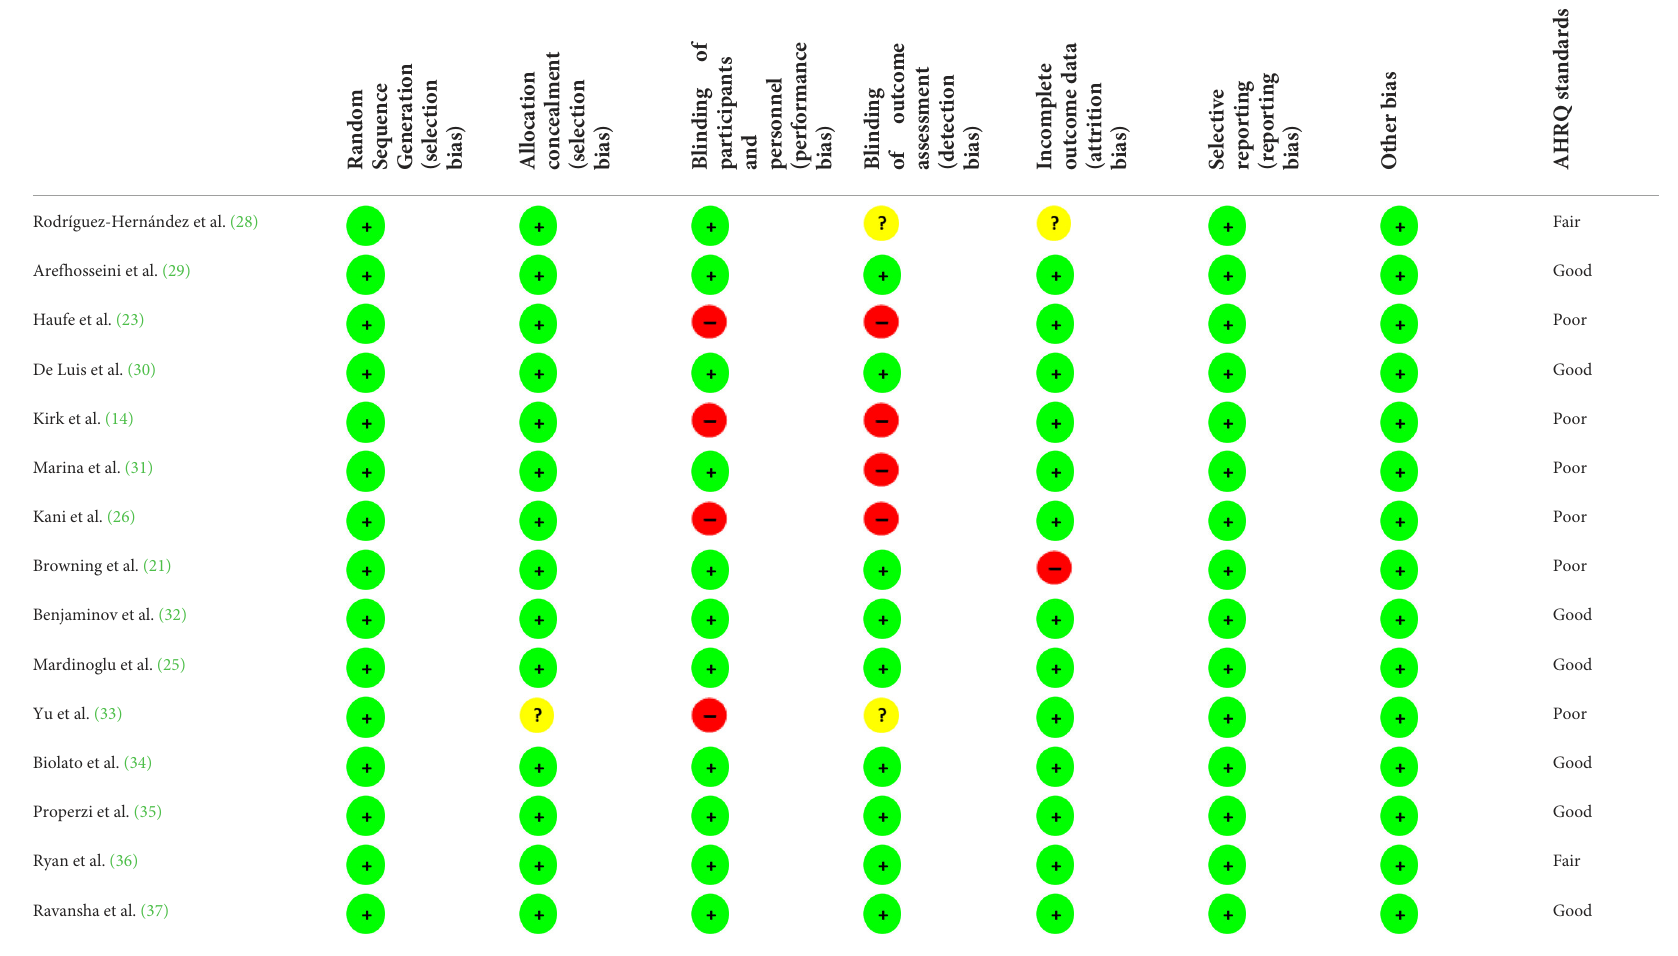
TABLE 1 The risk of bias in studies included in this